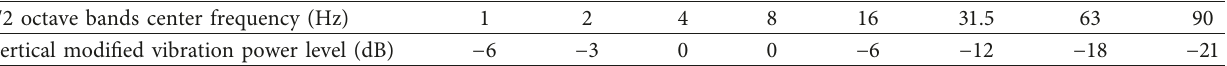
Figure 7: Human body response to different direction vibration. Table 3: Modification value of vertical effective acceleration within the center